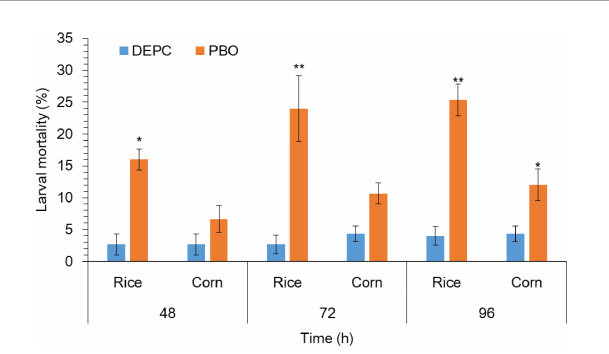
FIGURE 3 The impact of piperonyl butoxide (PBO) on larval mortality of FAW. 1 m L of PBO was applied to the pronotum of each third instar larvae and 1% (v/v) acetone only as a control using a hand applicator for 24 h followed by feeding on rice and host plants. After feeding on different rice and corn treatments and control, mortality and larval mass were recorded at 48, 72, and 96 h. Data shown are mean ± SE. Treatments were compared using Student ’ s t test. * and ** represent P < 0.05 and P < 0.01,